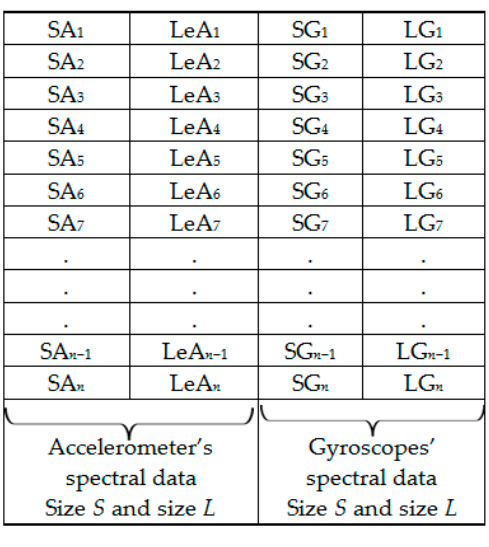
Figure 6. Set 1: OR dataset.